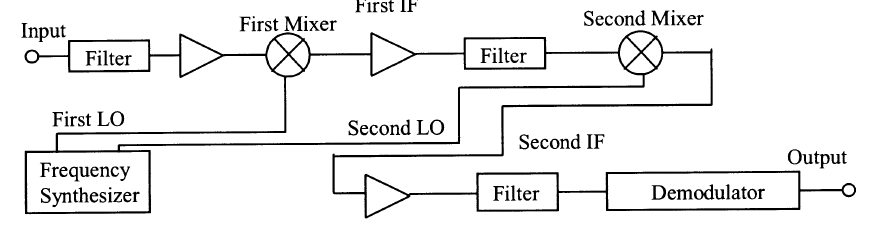
FIGURE 1 Dual conversion VHF = UHF communication receiver.